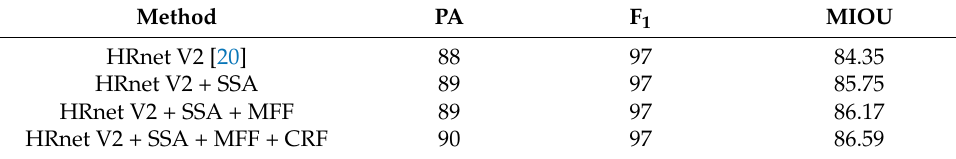
Table 3. Evaluation of water body extraction results obtained by different